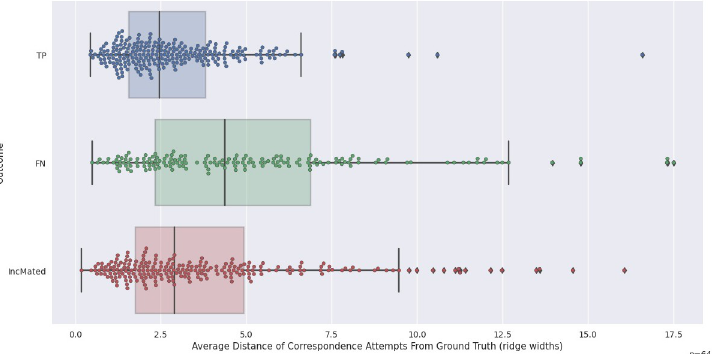
Fig 6. Average distance of correspondence attempts from ground truth, plotted against outcome. Only mated pairs have thin plate spline solutions that allow deviations computation. Note the large prevalence of FN and IncMated outcomes above 5 ridge widths. N = 644 because some trials have no correspondence attempts.